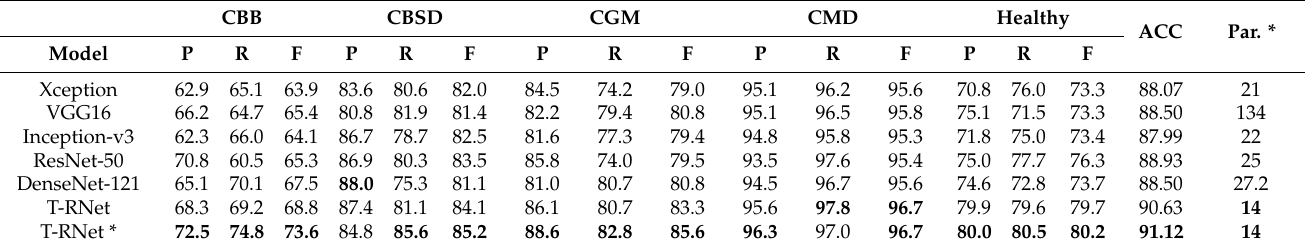
Table 3. Performance comparison of different classification methods on the cassava disease